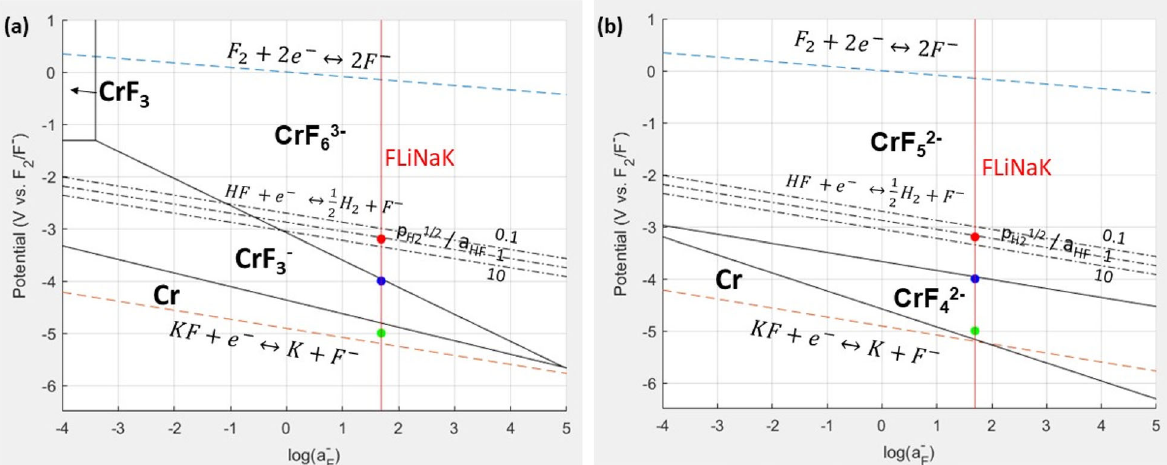
Fig. 4 Potential log(aF − ) equilibrium diagrams for Cr. a Considers the CrF 3 − and CrF 63 − species and ( b ) the CrF 42 − and CrF 52 − solvated states. The red, blue, and green dots at log(a F − ) = 1.693 mark the potentials for XRD results presented in Fig. 6. All Cr – F species were assumed to have an activity of 10 − 6 M.